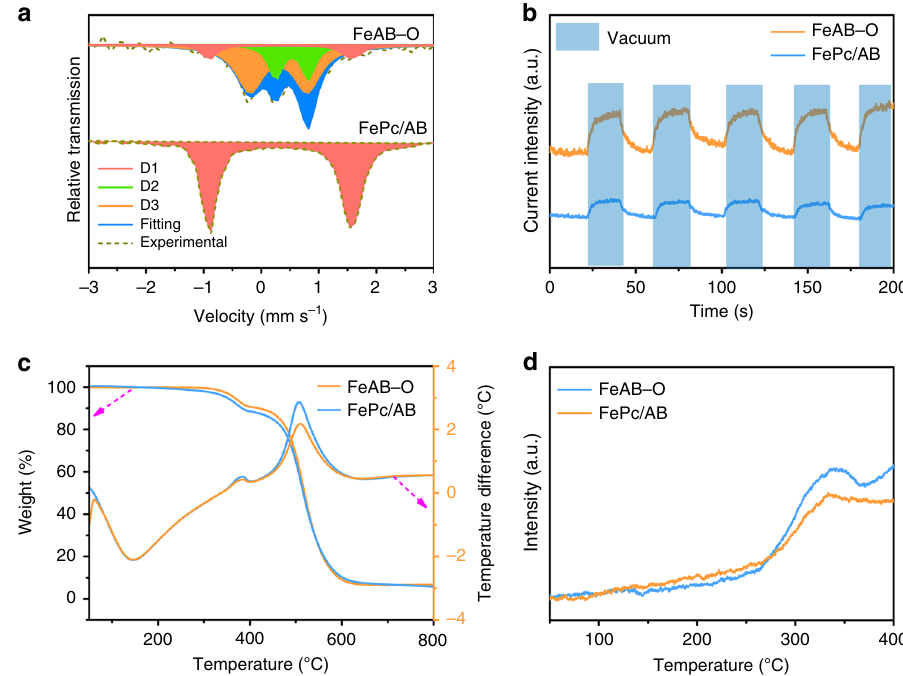
Fig. 3 The Oxygen adsorption ability. a 57 Fe Mössbauer transmission spectrum. b The oxygen adsorption – desorption tests. c TGA curves in air atmosphere. d The O 2 -TPD curves of FeAB – O and